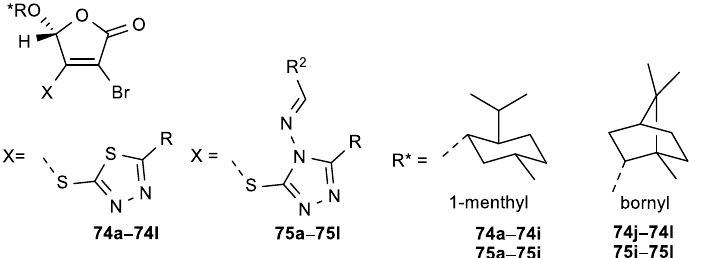
Figure 28. Butenolides substituted with 1,3,4-thiadiazoles ( 74a – l ) or 1,2,4-triazole Schi ff bases ( 75a – l ) at position C-3 of the lactone